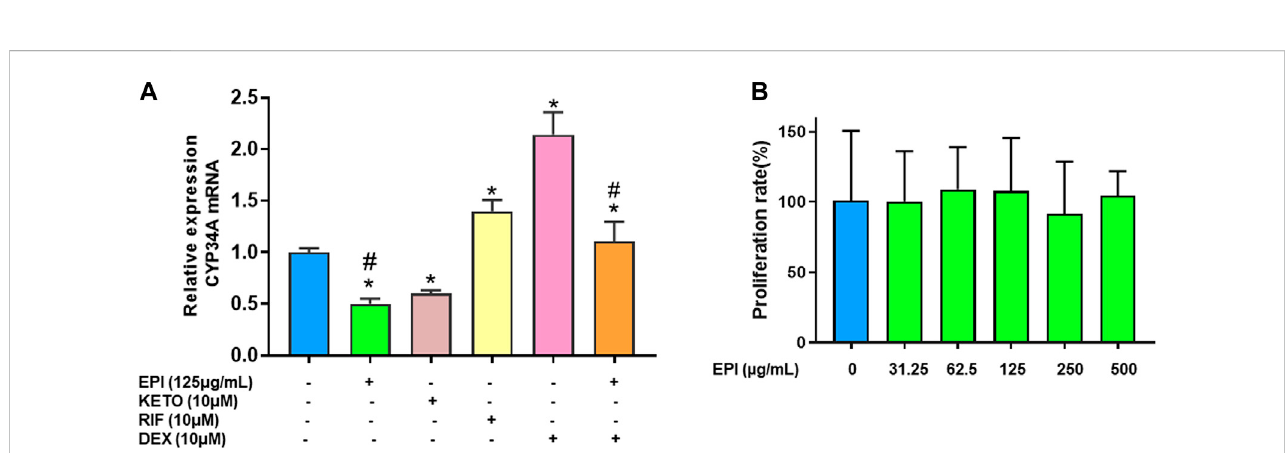
FIGURE 2 Epimedium suppressed CYP3A4 mRNA expression in human liver cell lines: HepG2 cells were cultured with Epimedium (EPI) and Dexamethasone (DEX) either alone or in combination. Rifampin (RI F)was used as a CYP3A4 enhancer whereas Ketoconazole (KETO) as a CYP3A4 inhibitor. The expression levels weredeterminedbyqRT-PCR.EPIalone inhibitedCYP3A4mRNAexpressioncomparabletoKETOwhereasDEXenhancedCYP3A4mRNAlevelscomparable to RIF. Coculture EPI and DEX remarkably reduced DEX enhancement of CYP3A4 mRNA levels (A) . Cell proliferation assay measured using MTT assay showed nodifferentinproliferationbetweengroups (B) .Datarepresentstriplicate experiments and expressed as mean ±SD.* p < .05 vs. control (0.1%DMS0), # p < 0.05 vs .